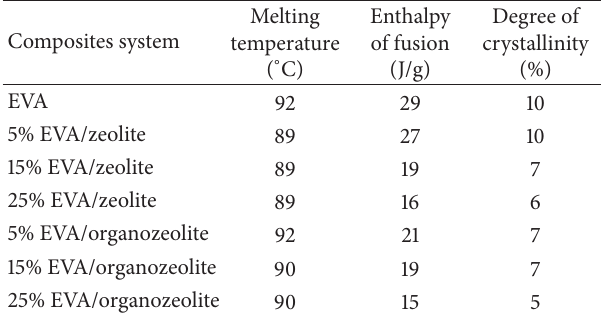
Table 3: DSC results of EVA matrix and its